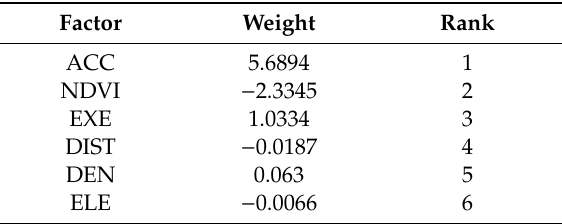
Table 8. Rank of